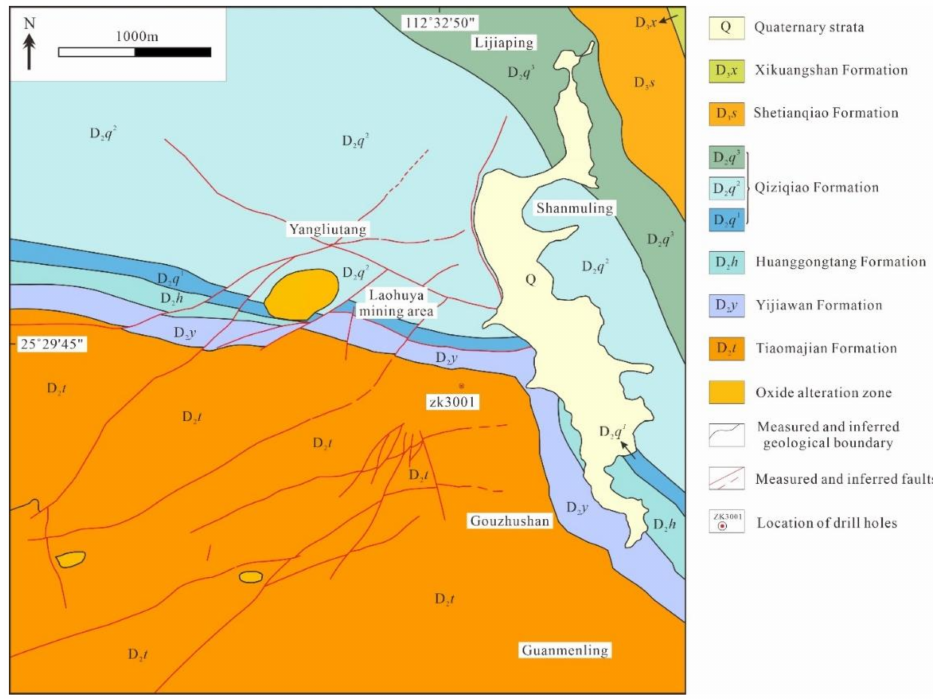
Figure 2. Geological sketch map of Laohuya mining